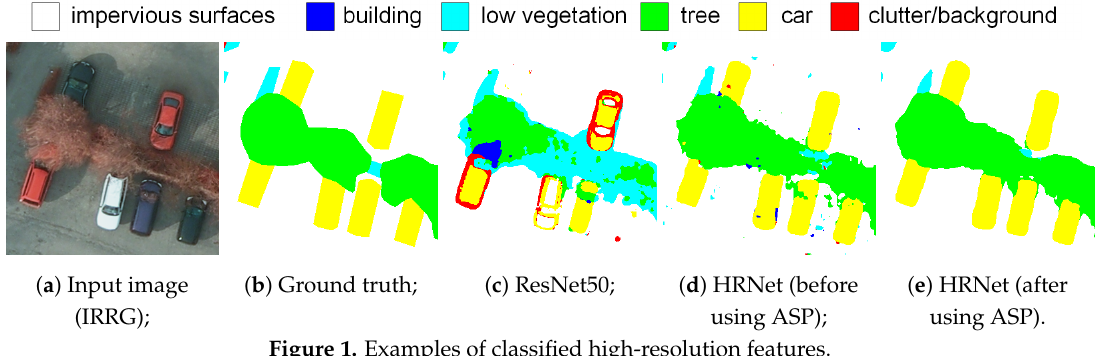
Figure 1. Examples of classified high-resolution